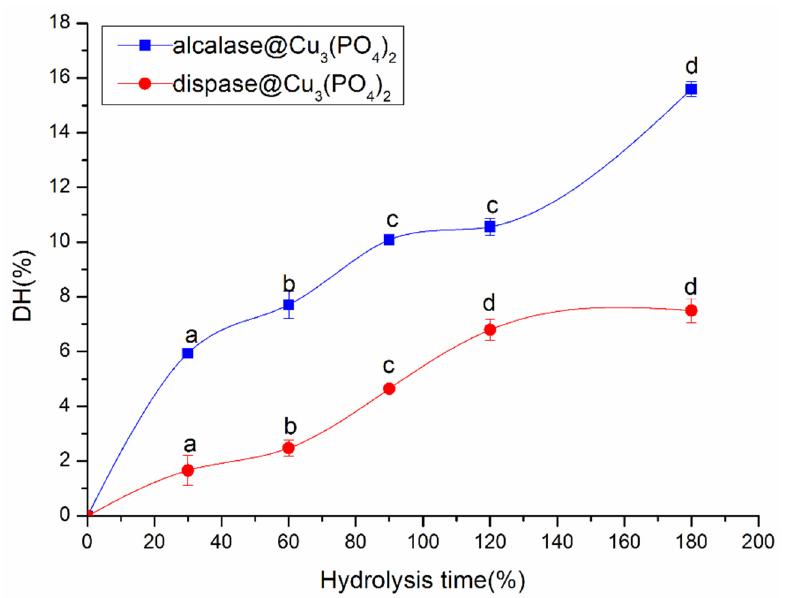
Figure 3. Hydrolysis curves of soybean protein hydrolyzed by ACHNs and DCHNs. Different letters (a–d) represent significant differences between the hydrolysis degrees obtained for different hydrolysis times of the same protease ( p < 0.05).